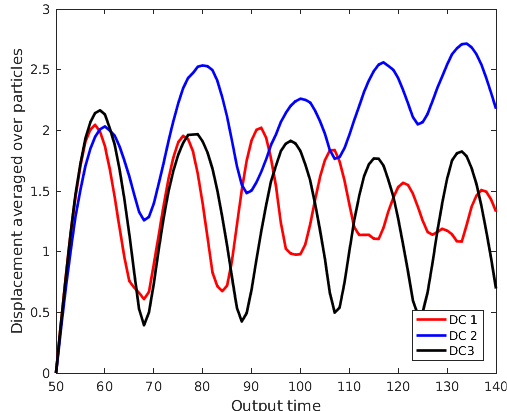
Figure 10. Displacement averaged over particles in dense clusters from clusters 1, 2 and 3 (DC 1, DC 2 and DC 3) measured from positions at output time 50 vs. output